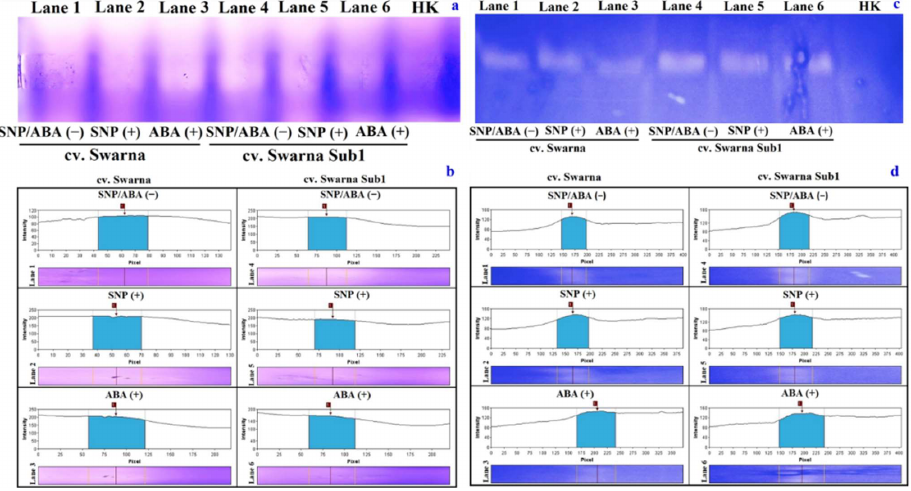
Figure 10. Changes in polymorphisms of ascorbate peroxidase and glutathione S-transferase (( a , c ), respectively) and their densitometric analysis (( b , d ), respectively) in two rice genotypes (cv. Swarna and Swarna Sub1) under salinity stress [SS (+)] and non-salinity stress [SS (−)] for 72 h with [SNP (+) or ABA (+)] or without [SNP/ABA (−)] priming for 24 h. Loading plot: HK- heat killed.